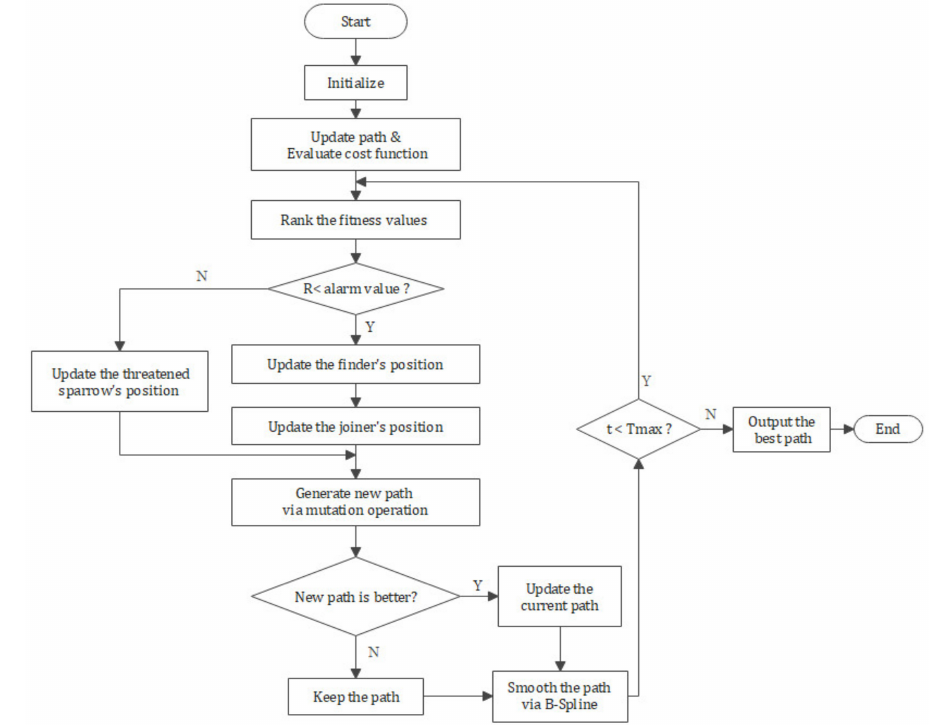
Figure 7. Flowchart of CASSA for 3d UAV route planning.